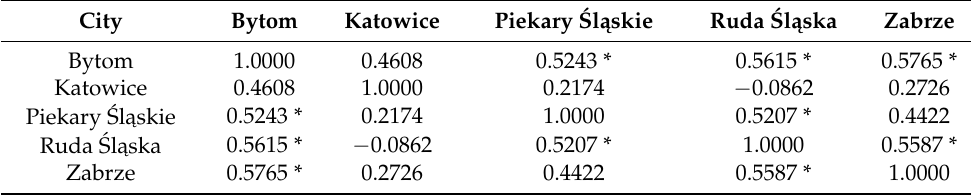
Table 5. Correlation table for the liabilities of the examined cities. City Bytom Katowice Piekary ´Sl ˛askie Ruda ´Sl ˛aska Zabrze Bytom 1.0000 0.9325 * 0.2929 0.2428 0.9297 * Katowice 0.9325 * 1.0000 0.1651 0.1123 0.8148 * Piekary ´Sl ˛askie 0.2929 0.1651 Ruda ´Sl ˛aska Zabrze 0.9297